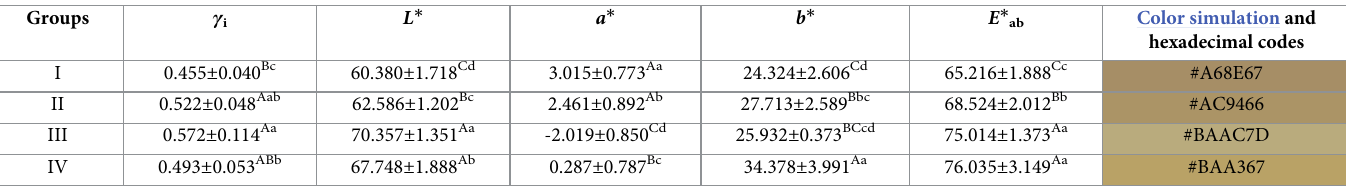
Different lowercase and uppercase letters indicated significant differences at 0.01 < P < 0.05 and P < 0.001, respectively; same lowercase and uppercase letters indicated no significant differences at P > 0.05 and P > 0.001,